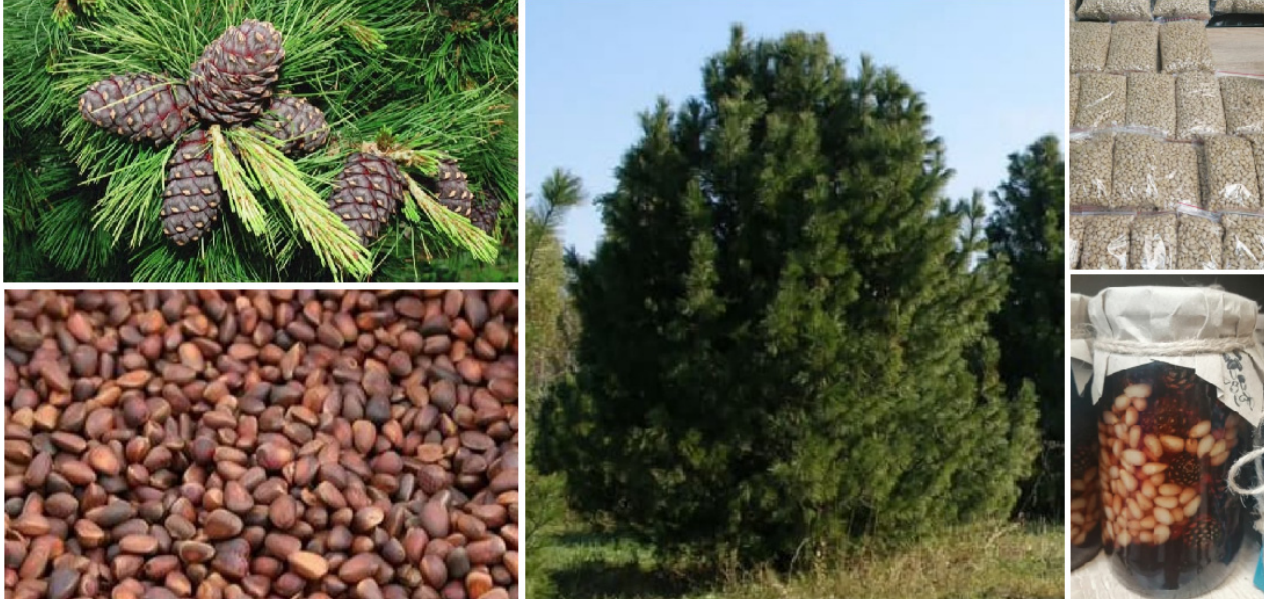
Figure 1. Siberian “cedar” ( center ), its pines and seeds ( left ), and some common products for sale ( right ).